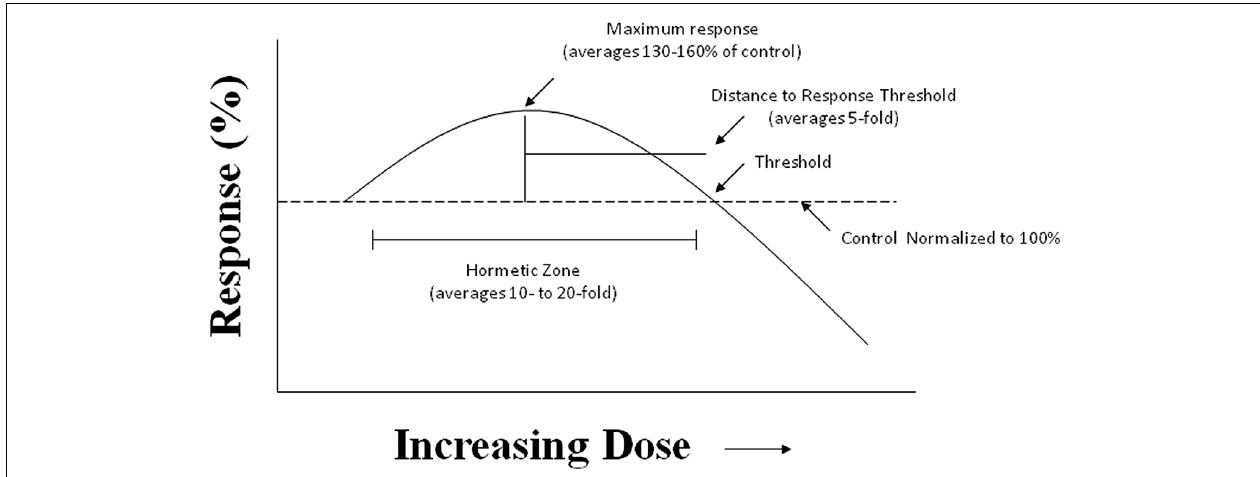
response following an initial disruption in homeostasis, in both cases being the quantitative features similar. The hormetic response appears to quantitatively describe the limits of biological plasticity across phyla as well as at different levels of biological organization (cell, organ, and organism). The quantitative features of the hormetic dose response are also independent of mechanism. Pharmaceutical treatments for a wide range of human conditions are based upon the hormetic biphasic dose response as discovered within preclinical evaluations and then directly applied to human